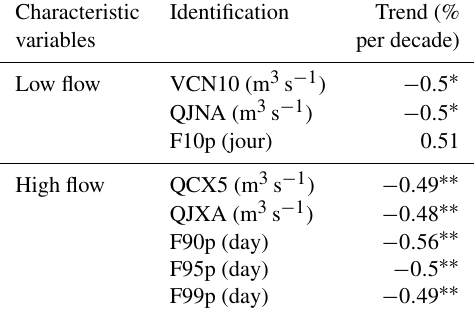
Table 4. Trend (% by decade) of high flow and low flow variables. Characteristic